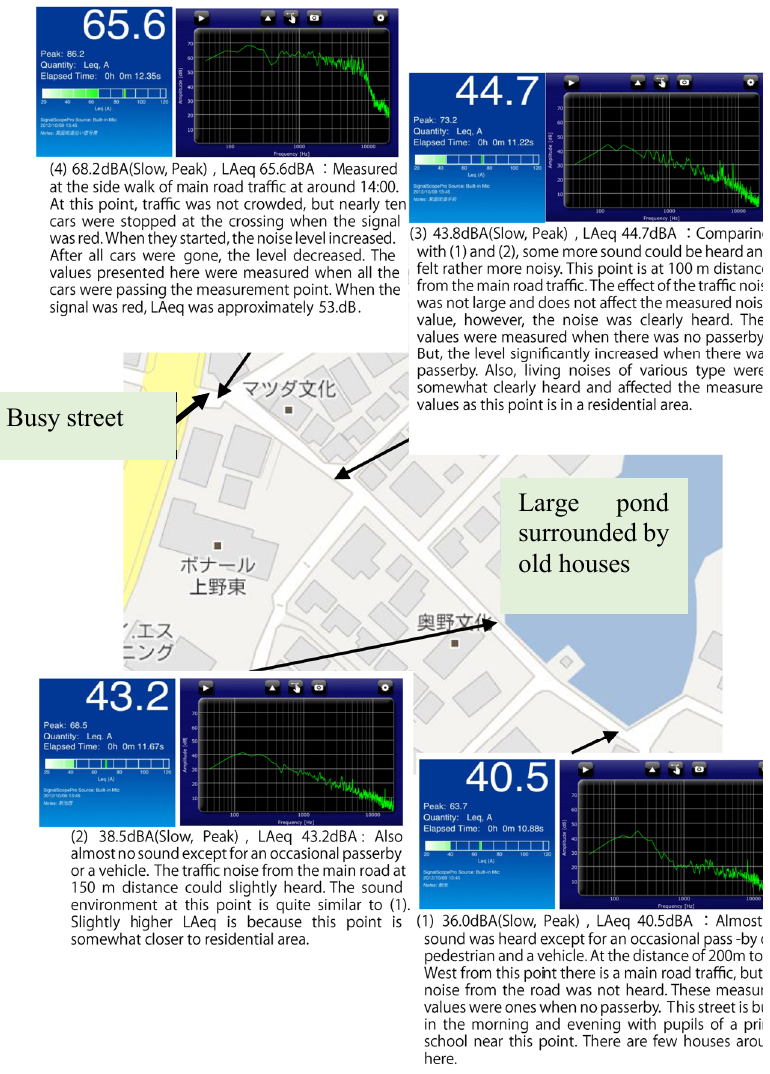
Figure 5. Example of sound map with Leq(A) (30 sec, Signal Scope Pro 7 on iPhone 5s), and sound spectrum (bs-spectrum on iPhone 5s): Ueno-higashi area, Toyonaka City, Osaka, Japan.